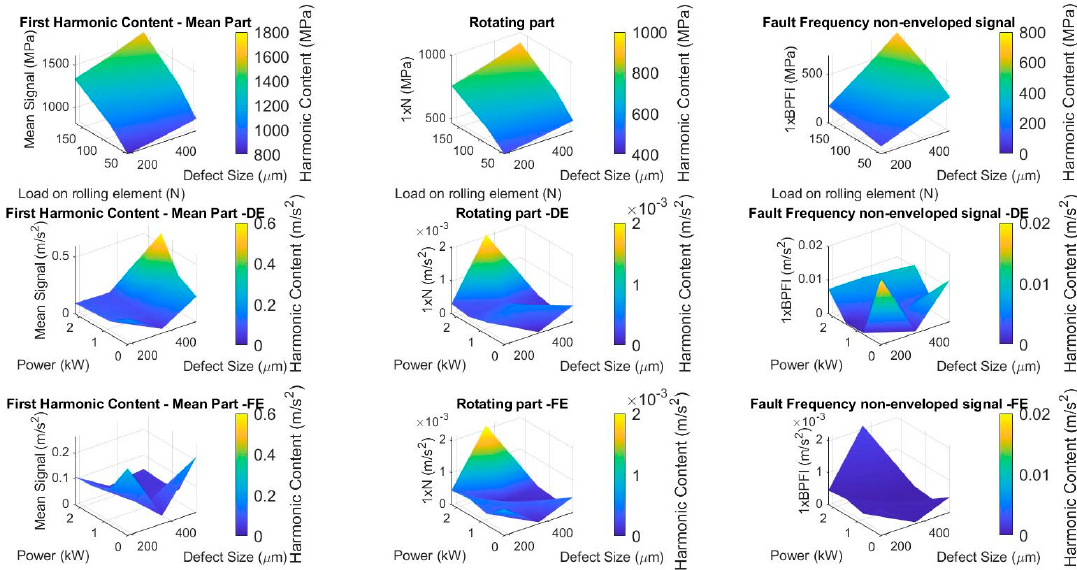
Figure 14. Frequency features analysis for contact pressure, DE and FE signals.